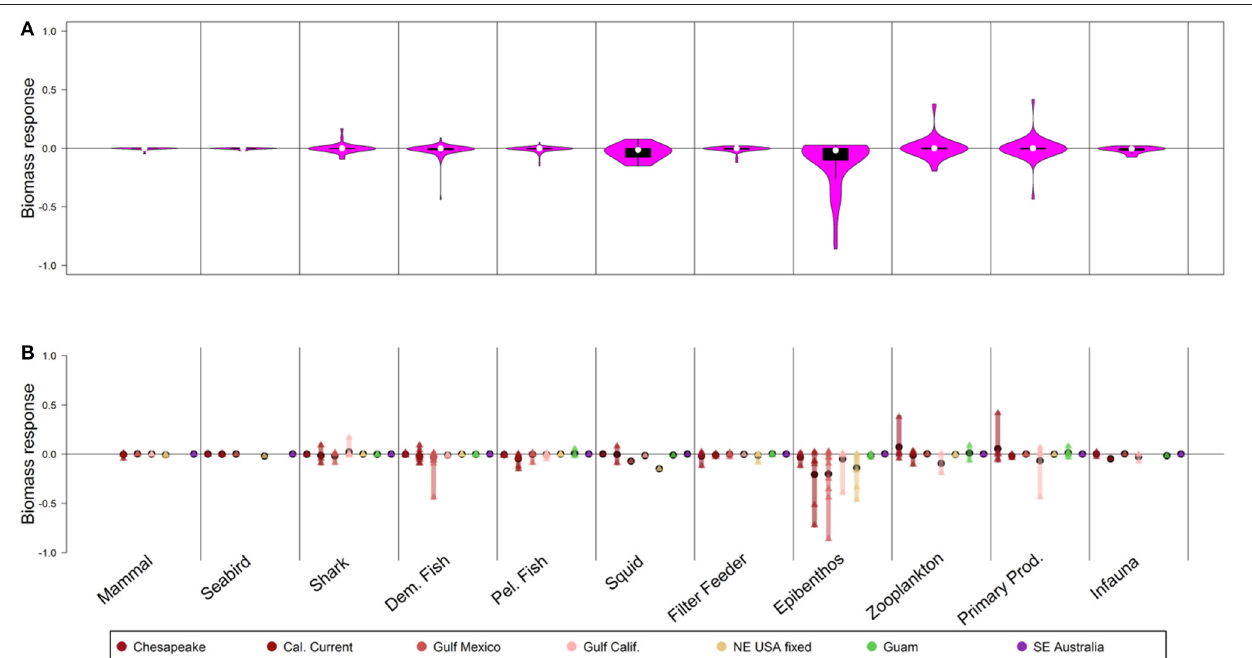
FIGURE 5 | Biomass response to 50-year scenarios with 2 × fishing mortality on invertebrates. Panel explanations as in Figure 2 .